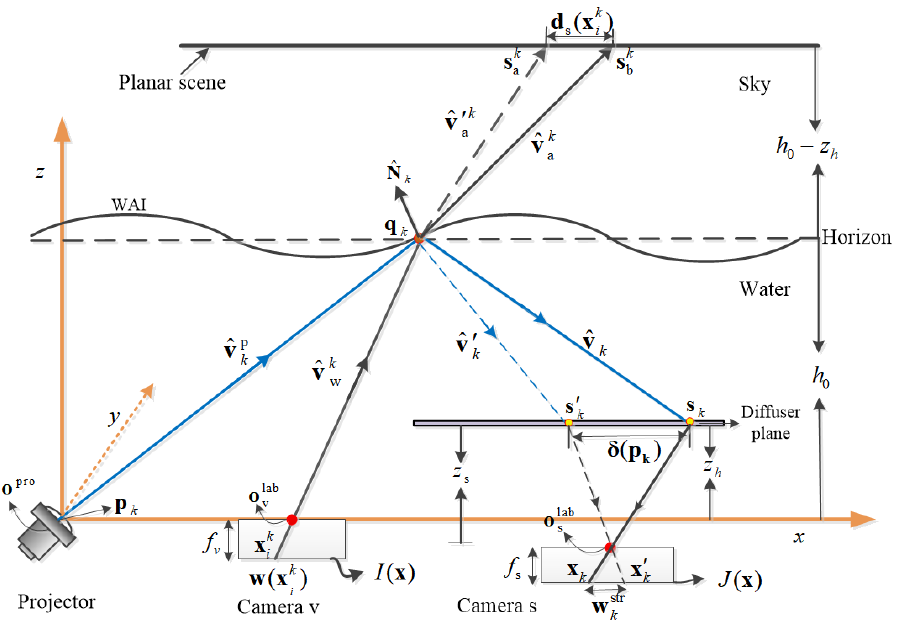
δ p is the amount of dis ‐ ) is the amount of displace- k k p v on the diffuser plane; ( ) k d x ^ ( x k ) is the v i k s k on the diffuser plane; d s i ˆ k v corresponding to the back ‐ projected k k ^ ^ a v v a corresponding to the back-projected ray w ; (cid:16) (cid:17) w and ( ) k w x k i x k and w are a pair of i k